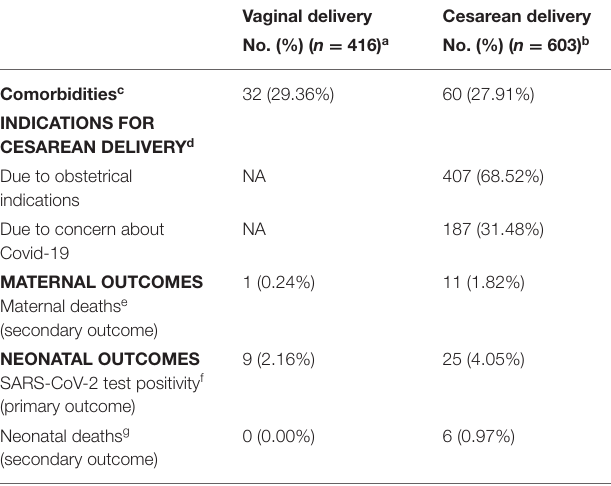
TABLE 2 | Maternal and neonatal outcomes by mode of